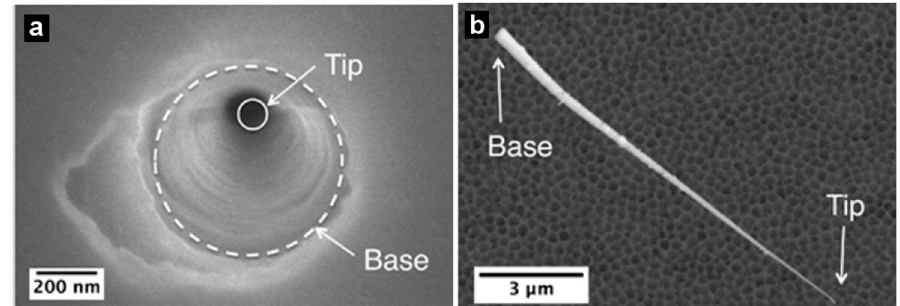
Figure 4. Scanning electron micrographs of ( a ) a base opening in a track-etched conical pore polyethylene terephthalate (PET) membrane and ( b ) a gold replica of a conical pore. Reproduced with permission from [33]. American Chemical Society, 2016.